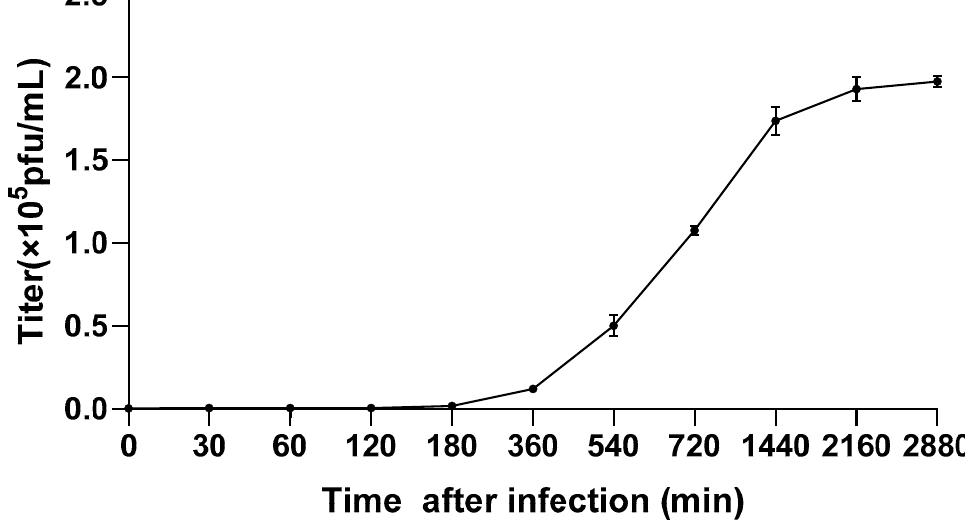
Figure 2. One-step growth curve of Mae-Yong1326-1 developed under the MOI of 0.1. Each dot represents the average titer at each time from the three parallel experiments. Error bars indicate standard deviations.